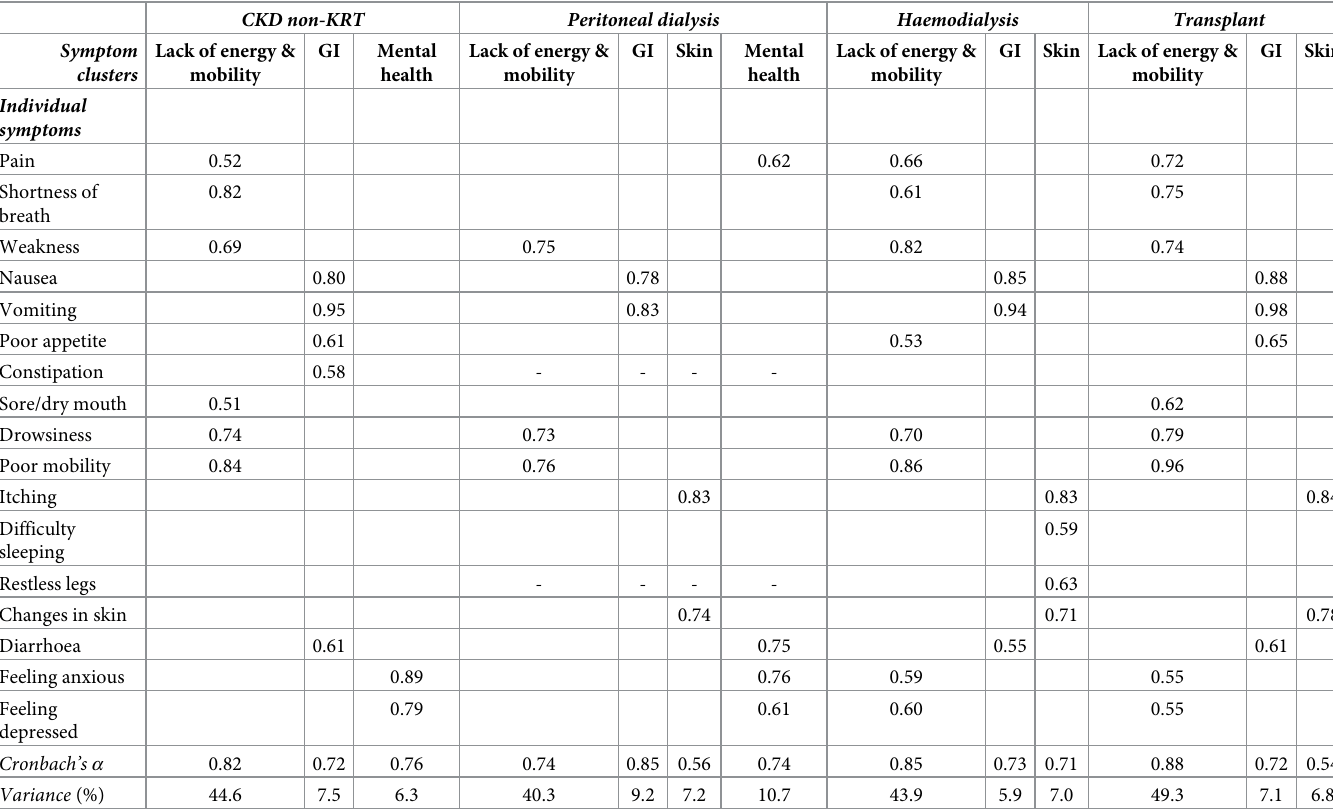
Table 2. Clusters, symptom loadings and internal consistency (Cronbach’s ɑ ) resulting from principal component analyses. CKD